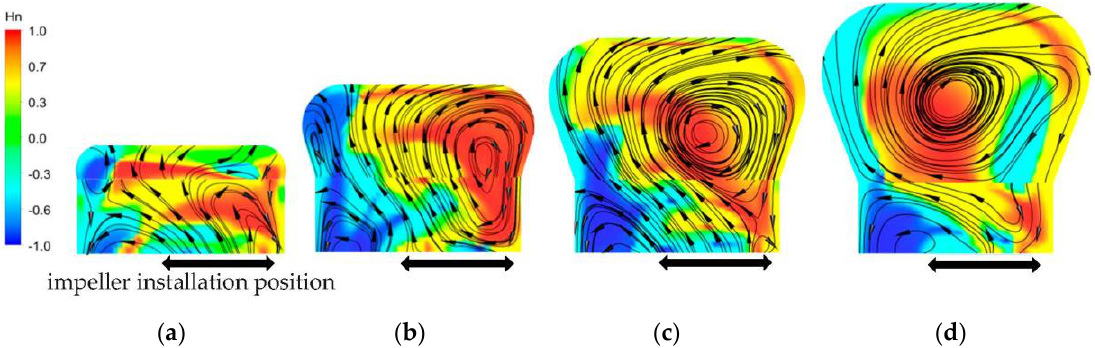
Figure 13. H n and velocity curves of volute section: ( a ) Section I; ( b ) Section III; ( c ) Section V; ( d ) Section